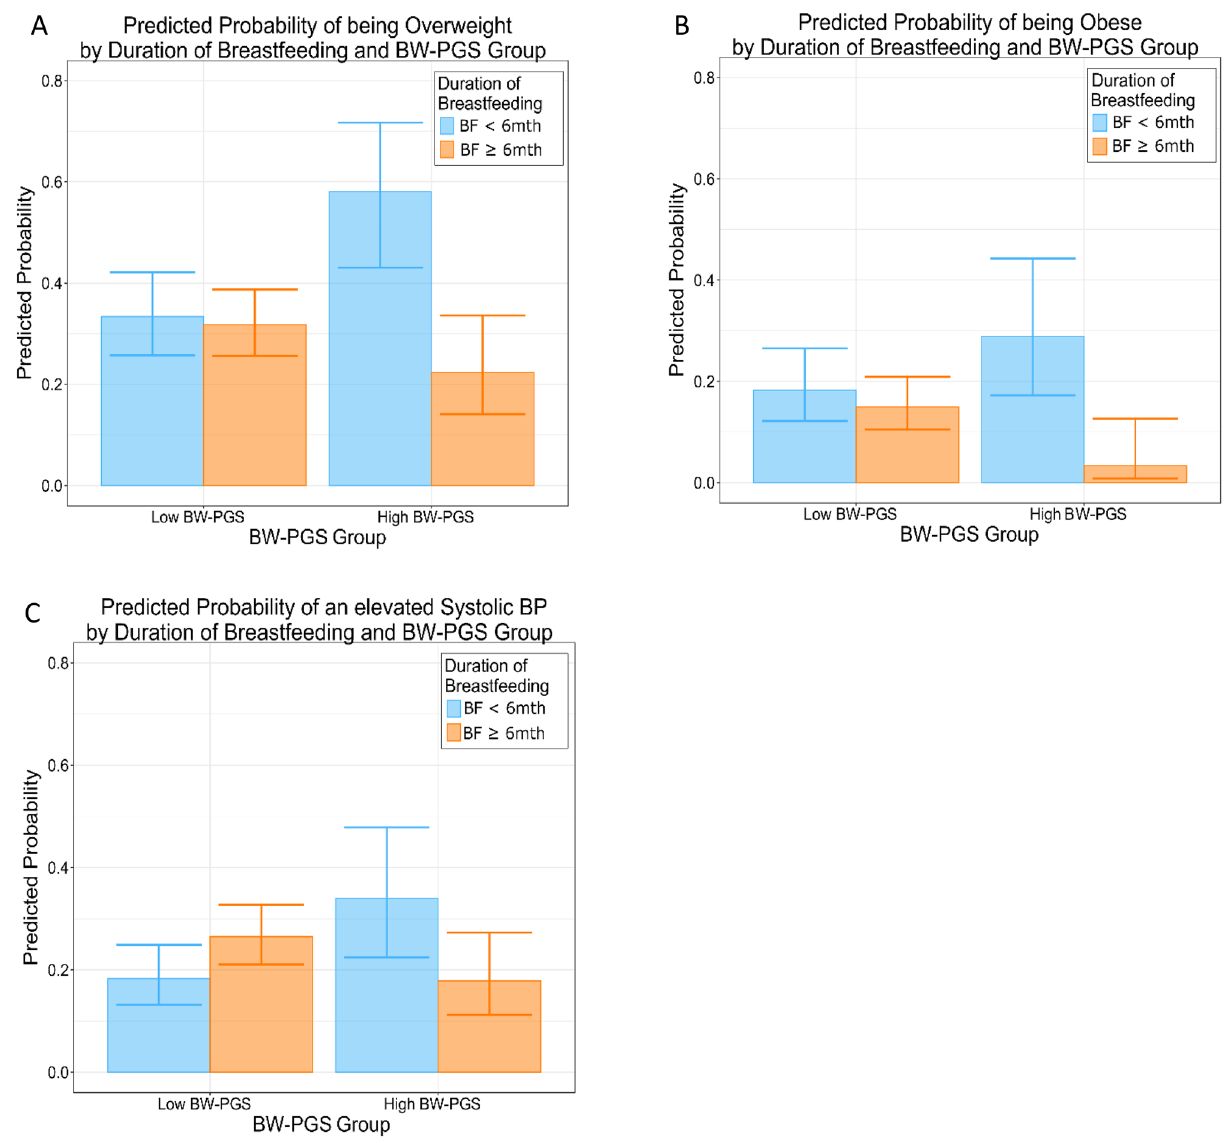
Figure 3. Predicted probability of adverse adult health outcomes at 22 years of age by BW-PGS group (High vs Low) and Duration of any Breastfeeding (< 6 months vs ≥ 6 months). A low BW-PGS is defined as those in the 0-80th percentile of the BW-PGS within the Raine Study participants, while a high BW-PGS is defined as those in the highest quintile (80-100th percentile) of the BW-PGS within the Raine Study participants. ( A ): Predicted probability of being obese (BMI ≥ 25 kg/m 2 ) at 22 years of age by BW-PGS and duration of breastfeeding; ( B ): Predicted probability of being obese (BMI ≥ 30 kg/m 2 ) at 22 years of age by BW-PGS and duration of breastfeeding; ( C ): Predicted probability of being an elevated systolic BP (SBP ≥ 120 mmHg) at 22 years of age by BW-PGS and duration of breastfeeding. (Figure generated using ggplot2 in Refs. 37,38